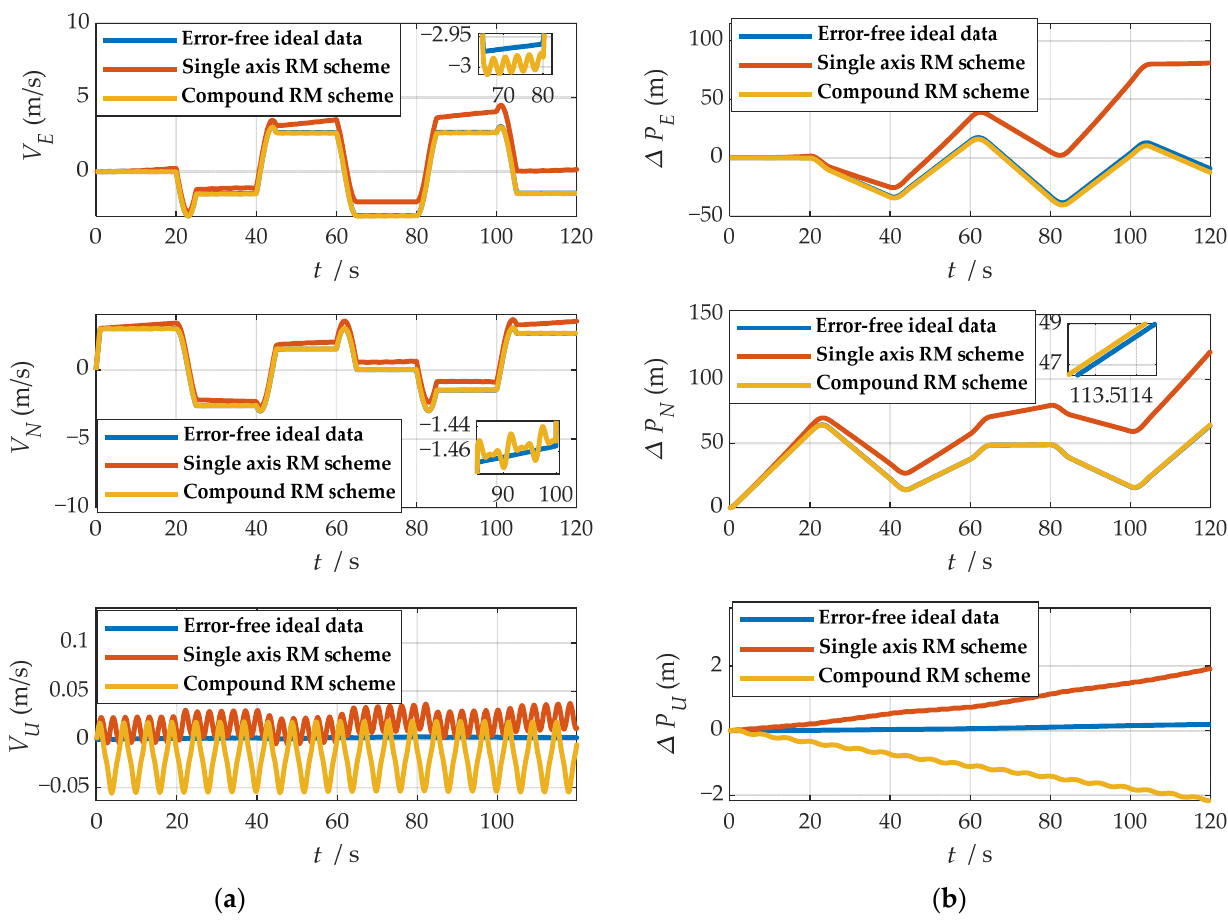
Figure 15. Comparison of velocity and position results in three directions: ( a ) comparison of velocity results in three directions; ( b ) comparison of position results in three directions.